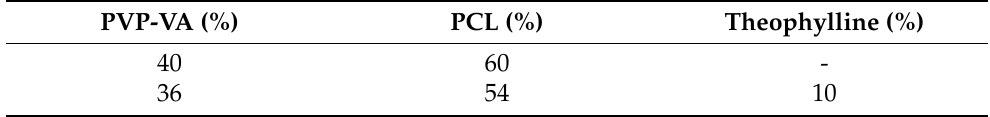
Table 1. Placebo and drug-loaded formulation